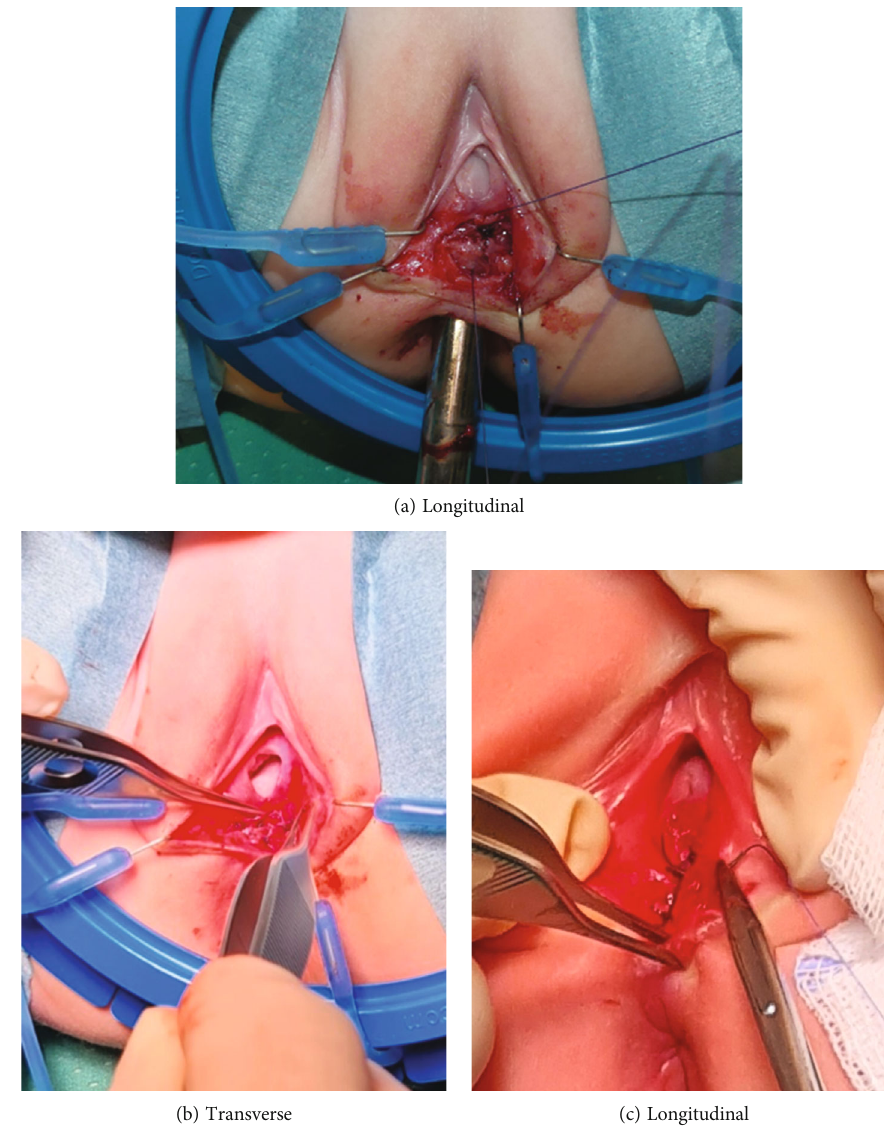
Figure 3: Layered closure with nonoverlapping suture